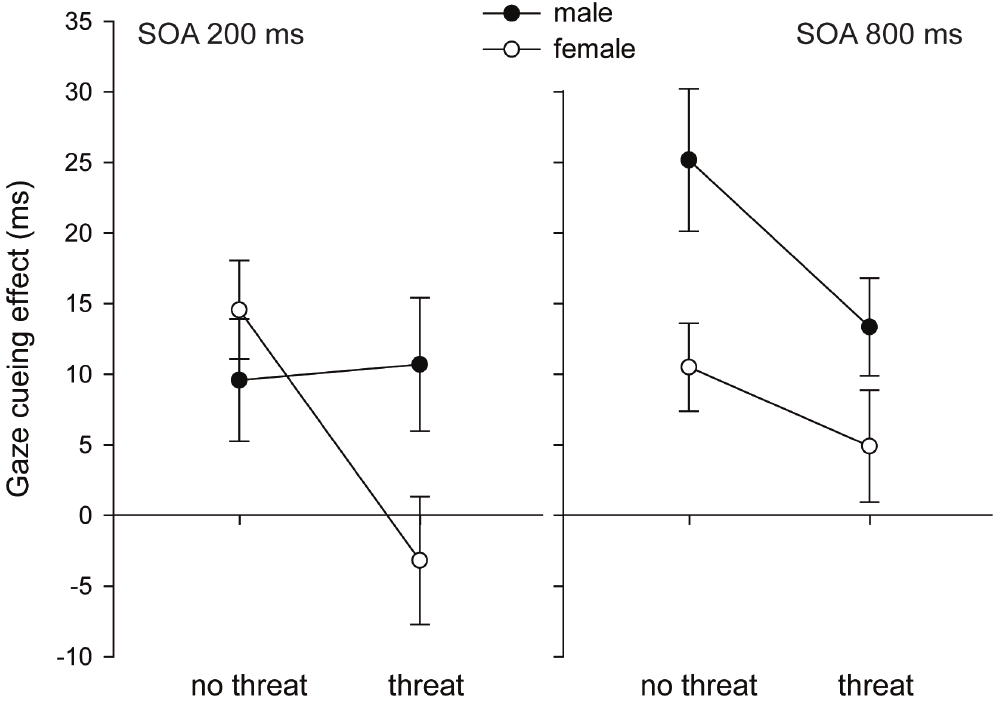
Figure 2. Threat and gender modulate gaze following. Significant interaction effect between: Prime condition, SOA and Face ( F (1,44)=4.36, p =.043), the error bars in the figure represent within-subject standard error of the mean.